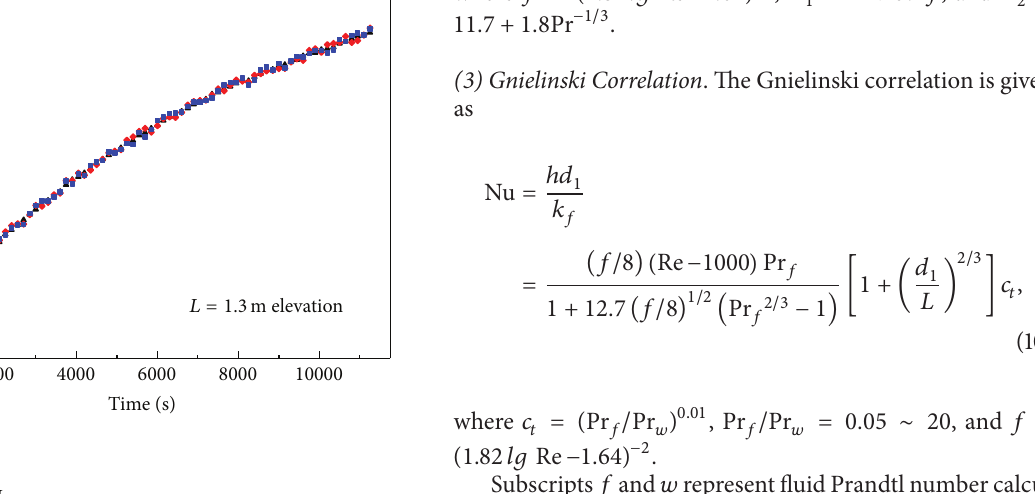
11280 seconds, the vertical temperature gradient between the top tank elevation (1.3 m) and bottom elevation (0.05 m) is about 27